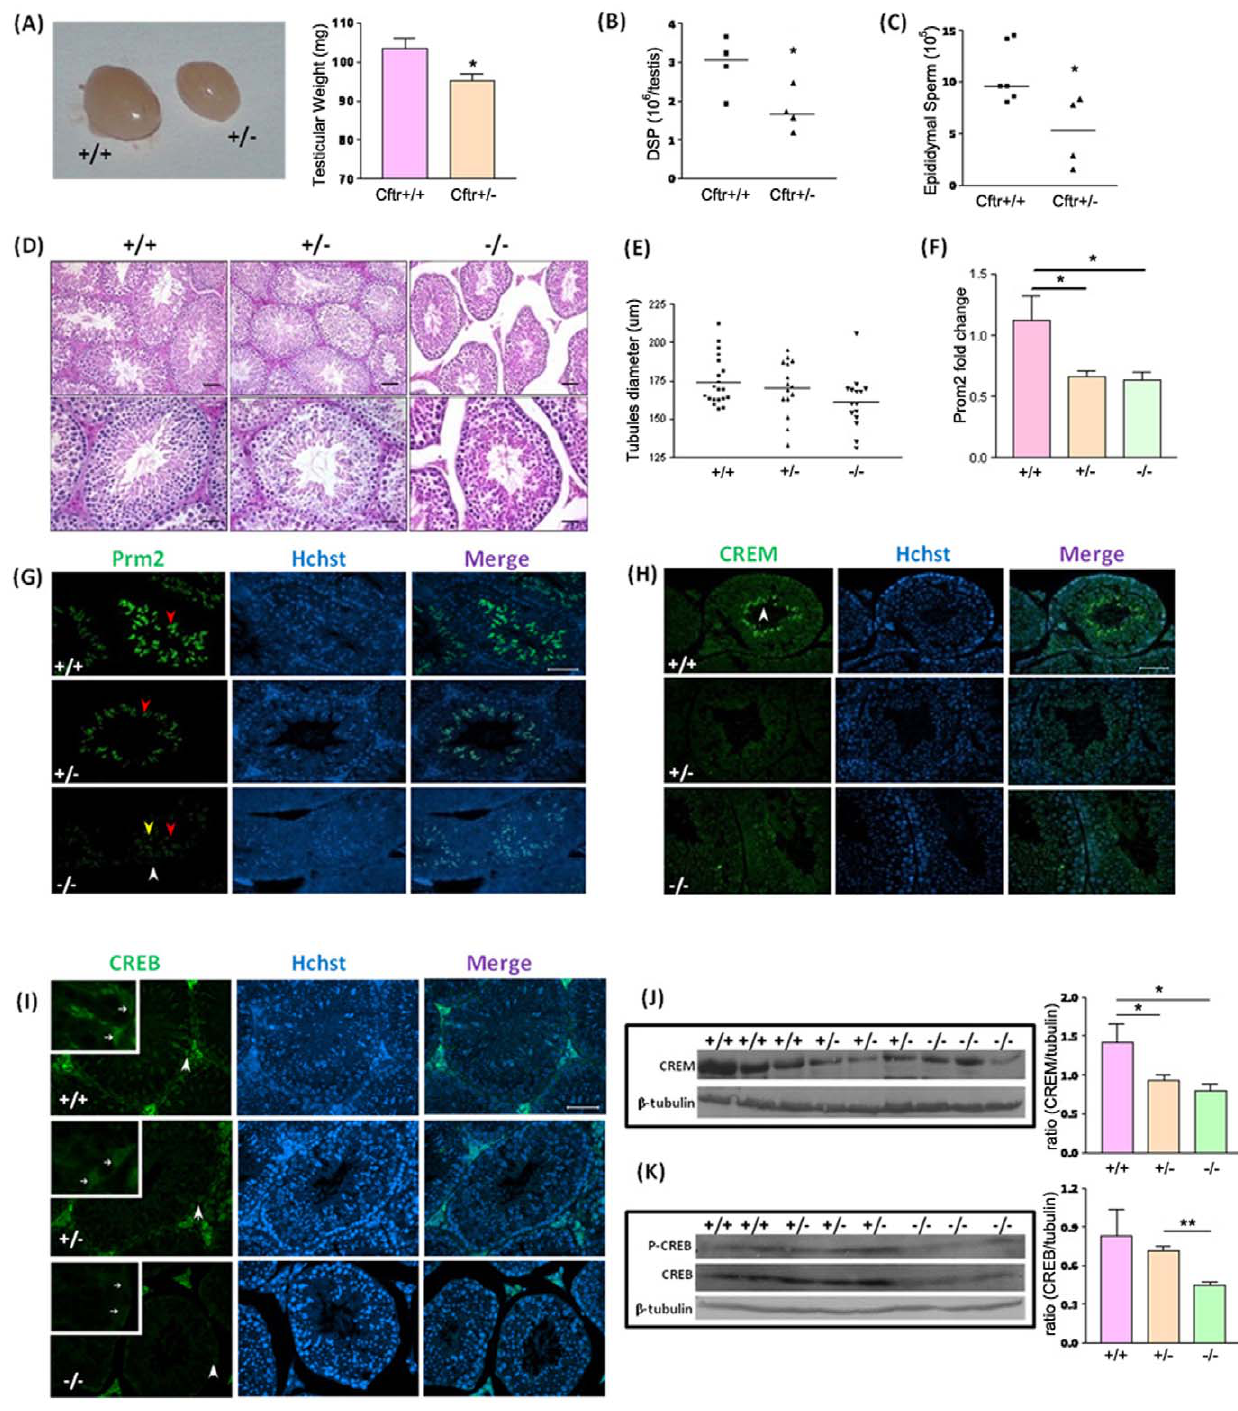
Figure 1 . Defective spermatogenesis and altered expression of CREB in CF mice testis. ( A ) Significantly reduced testis size and weight seen in heterozygous S489X mice compared with wild-type mice (n=3; *:p , 0.05). ( B ) Reduced daily sperm production (DSP) values retrieved from heterozygous S489X testes (n=4; *:p , 0.05). ( C ) Reduced sperm numbers recovered from the epididymis of heterozygous S489X mice ( + / + n=6, + / 2 n=4; *:p , 0.05). ( D ) H&E staining of the cross sections of wild 2 type, heterozygous and homozygous S489X CF mice testes. Seminiferous tubules remain intact in + / 2 and 2 / 2 CF mice, but looser tubule contacts with larger interstitial space are observed in 2 / 2 testes (right) when compared with wild type (left). Leydig cells and peritubular myloid cells are detached from most tubules in 2 / 2 testes. Bar =20 m m (upper panel) or 50 m m (lower panel). ( E ) Statistic shows slight decrease in tubular diameter is observed in 2 / 2 testes. ( F ) Realtime PCR of protamine-2 in S489X CF mice testes. Protamine-2 mRNA level is significantly lowered in heterozygous and homozygous S489X CF mice compared to their wildtype littermates. ( G ) Immunofluorescent staining of Protamine-2 in + / + , + / 2 and 2 / 2 S489X CF mice testes (stage VII–VIII). In + / + testes, Protamine-2 positive signals are located in elongated spermatids (ES) with strong immunoreactivity (red arrow). In + / 2 testes, Protamine-2 is found in ES with moderate immunoreactivity (red arrow). In 2 / 2 testes, there is weak intensity in the pachytene spermatocytes (P) (white arrow), ES (red arrow) and round